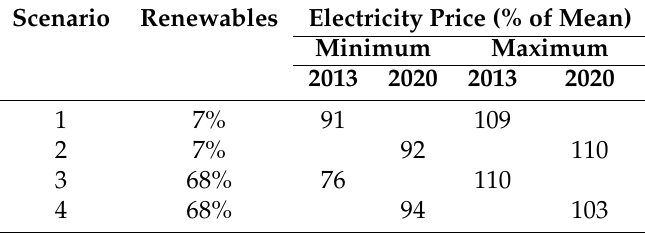
Table 2. Maximum and minimum prices as percentage of mean prices for individual scenario.